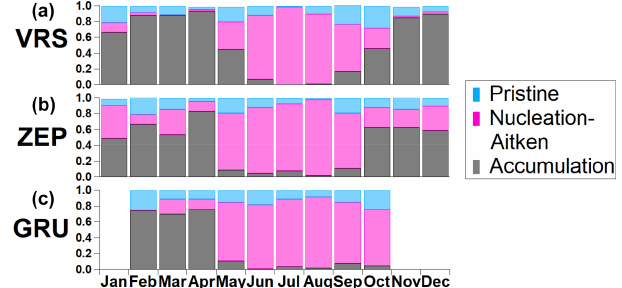
Figure 5. Average monthly occurrence of the classes of size dis- tribution categories for the three sites, for the entire data period. The nucleation- and Aitken-mode-dominated classes are binned to- gether, while the individual pristine category is shown individually. (a) Villum Research Station, (b) Zeppelin Mountain and (c) Gruve- badet.